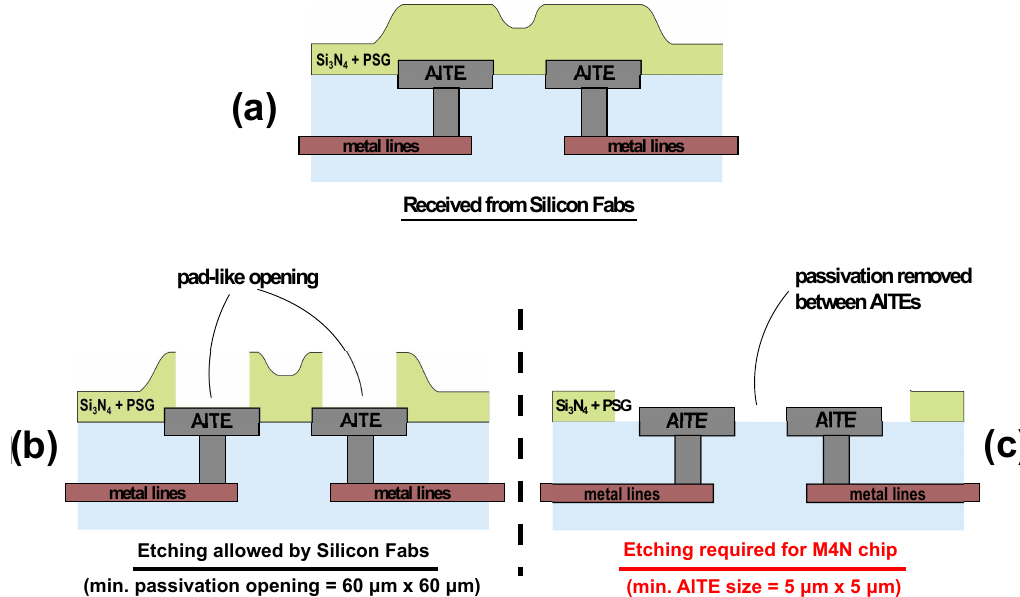
Figure 2. Etching of passivation film onto the M4N chip: ( a ) the chip received from semiconductor fab; ( b ) the standard solution for opening windows and ( c ) the required M4N solution for nanowire